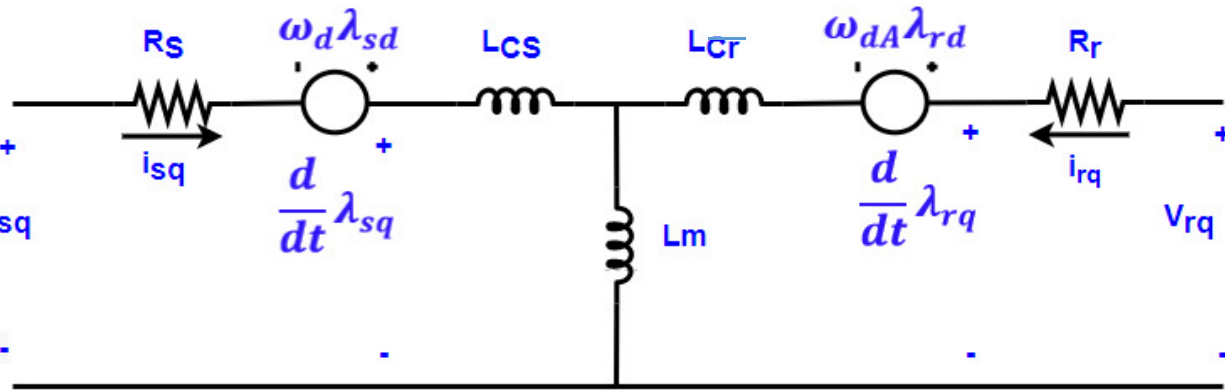
Figure 3. Induction motor equivalent circuit for the d-axis.